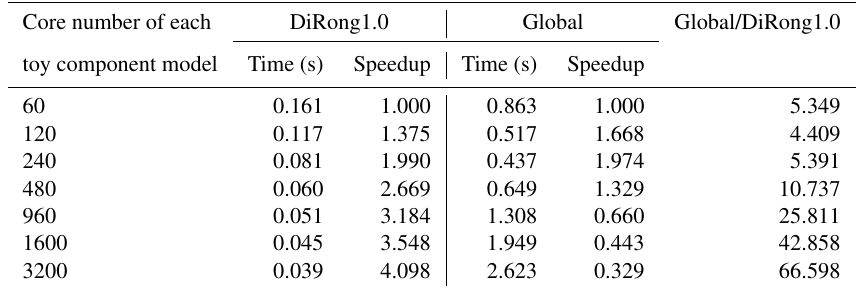
Table 8. Performance of DiRong1.0 and the comparison with the original global routing network generation (Global) using different numbers of cores numbers and the grid size of 4000000.